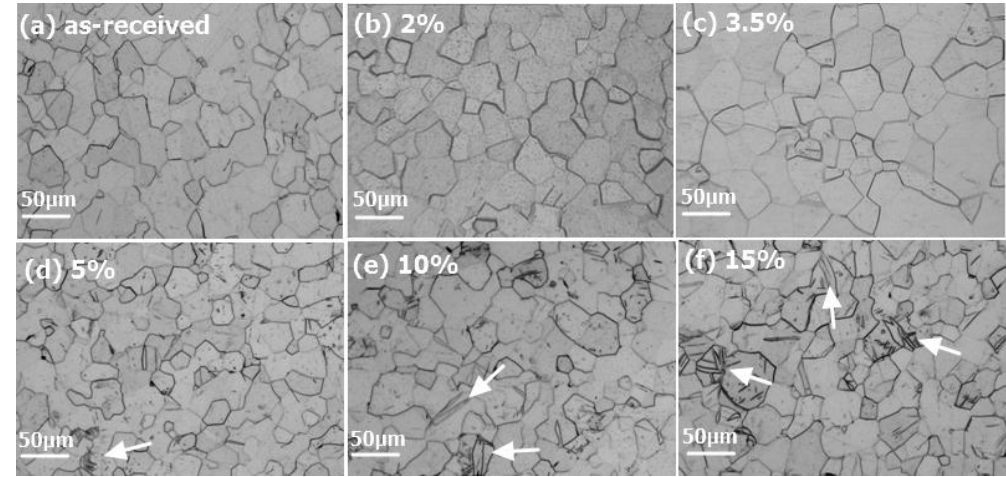
Figure 5. Metallographic figures of different prestrained samples: ( a ) as-received; ( b ) 2%; ( c ) 3.5%; ( d ) 5%; ( e ) 10% and ( f ) 15% prestrained specimens. Twins are indicated by white arrows in Figure 5 d – f .